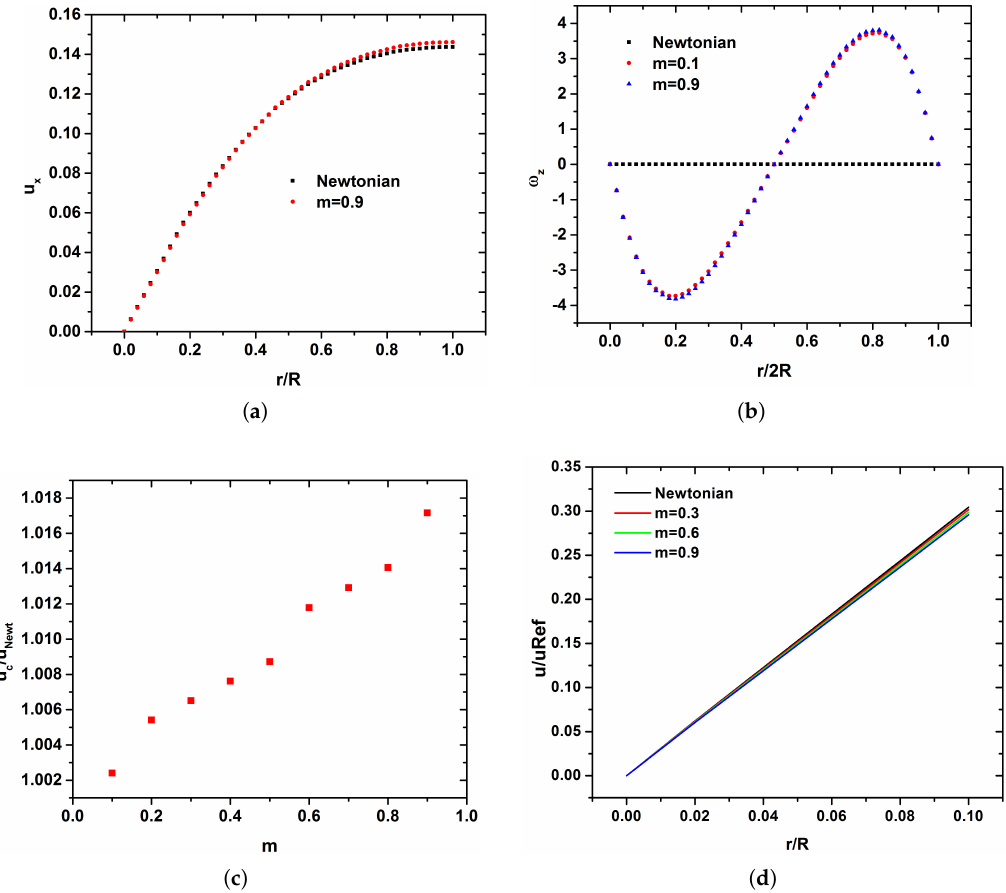
Figure 7. Blood ( a ) velocity, ( b ) microrotation, ( c ) velocity in the center of the tube, and ( d ) velocity near common carotid’s